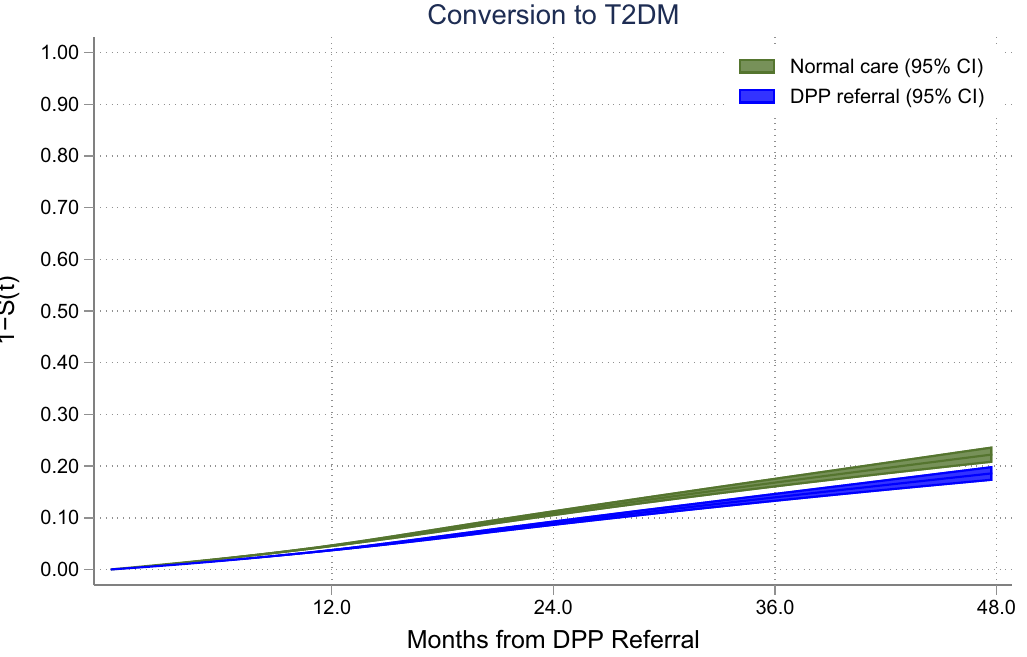
Fig 2. Conversion of patients referred to the programme and those who received normal care in primary care in the study period. (Since the flexible parametric model command we used to obtain average survival curves (stpm2) does not allow